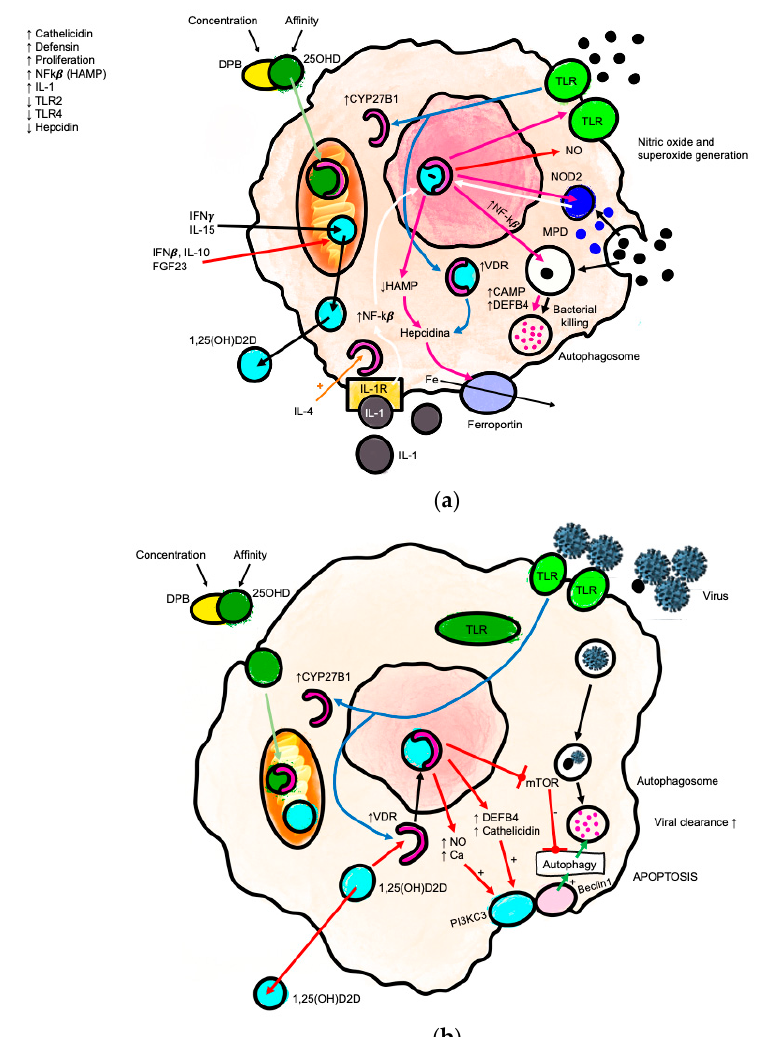
Figure 3. ( a ) Mechanisms for the induction of VDES-mediated antibacterial responses in monocytes. Pattern recognition receptors (TLR2/1) detect germs to induce the expression of CYP27B1 and VDR. The resulting intracrine system for vitamin D (blue arrows) converts calcifediol (25-hydroxyvitamin D (25OHD)) into calcitriol (1,25-dihydroxyvitamin D (1,25(OH)2D)), which then binds to the VDR and promotes transcriptional regulation. Responses to intracrine activation of the VDES (pink arrows) include the following: induction of antibacterial cathelicidin (CAMP) and β -defensin 2 (DEFB4); iron-regulating hepcidin (HAMP) suppression; promotion of autophagy; induction of NOD2 expression; feedback regulation of toll-like receptor expression (TLR); and increased destruction of bacteria. For some responses, accessory immune signals (MDP-noD2 binding and IL-1 responsiveness) cooperate with the intracrine VDES through nuclear factor κ B (NF- κ B) (white arrows). ( b ) Antiviral actions of the VDES and the innate immune response: autophagy/apoptosis. Autophagy is a fundamental biological process that maintains cellular homeostasis through the encapsulation of the intracellular membrane of damaged organelles and misfolded proteins. Autophagy is also an essential mechanism by which cells cope with viruses. Autophagic encapsulation of viral particles packages them for lysosomal degradation and subsequent presentation of antigens and adaptive antiviral immune responses. Therefore, autophagy may be highly sensitive to changes in serum 25(OH)D levels. The specific mechanisms that enable the VDES to promote autophagy involve downregulation of the mTOR pathway, which inhibits autophagy, and promotion of Beclin 1 and PI3KC3, key autophagy- driving enzymes. The upregulation of intracellular Ca and NO by VDES also stimulates the activity of PI3KC3 to promote